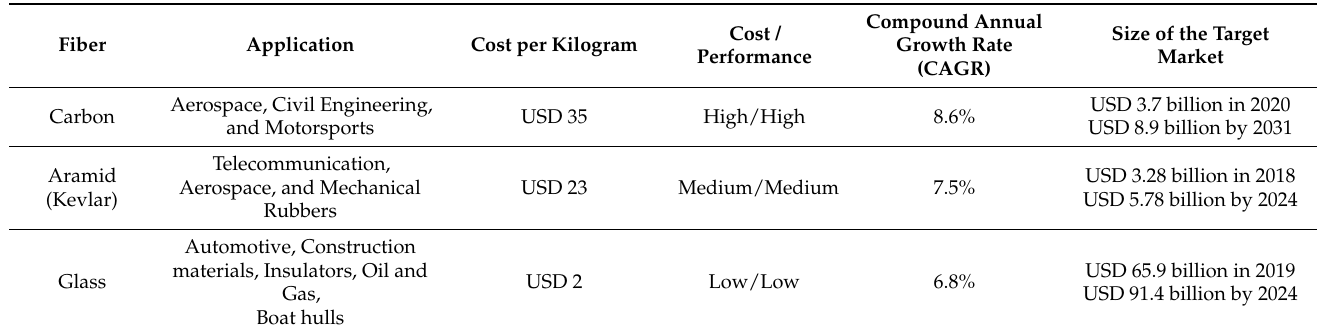
Table 3. Target application and market assessment of typical reinforcing